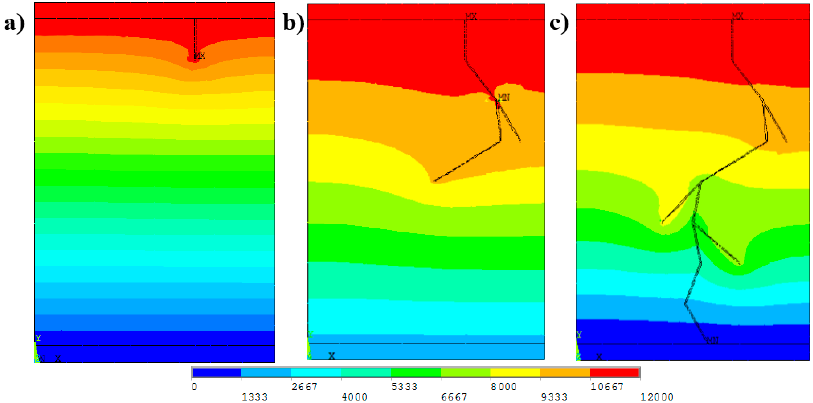
Figure 12. Distributions of potential values during prebreakdown stage (streamers) for di ff erent timesteps. (a): τ = 3.6 μ s; (b): τ = 9.6 μ s; (c): τ = 12 μ s timesteps. ( a ): τ = 3.6 µ s; ( b ): τ = 9.6 µ s; ( c ): τ = 12 µ